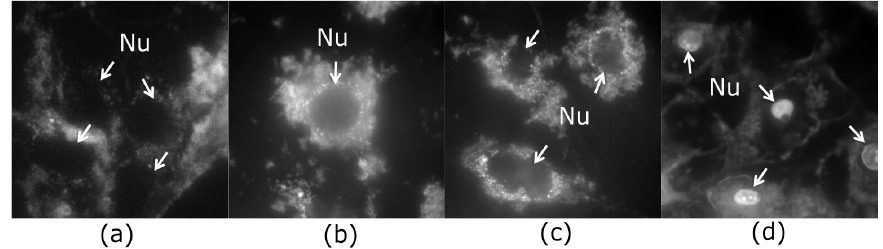
Figure 1. Fluorescent imaging of NIH/3T3 cells exposed to QCDs for 24 h: ( a ) 50 µg/mL; ( b ) 100 µg/mL; ( c ) 200 µg/mL; ( d ) 400 µg/mL; “Nu” and arrows denotes the nuclei. FMS, field of view 91 µm.